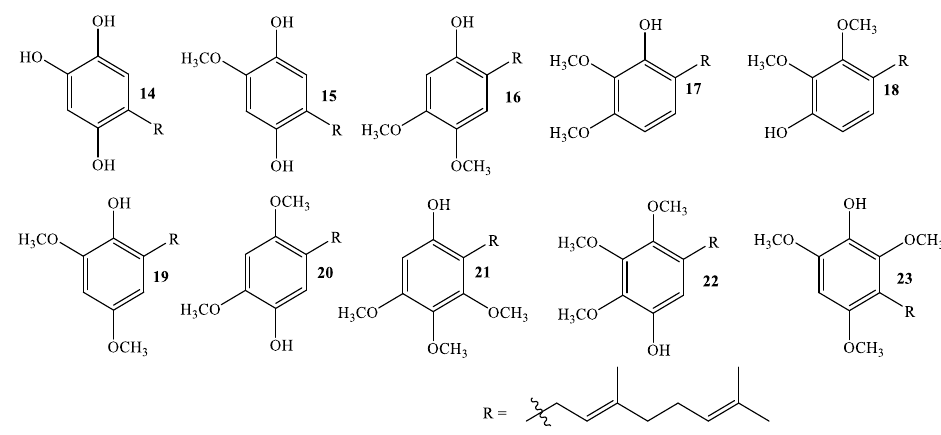
Figure 2. Structure of new ( 14 , 17 , 18 , 21 ) and other structurally related linear geranylated phenols/methoxyphenols (Group II).